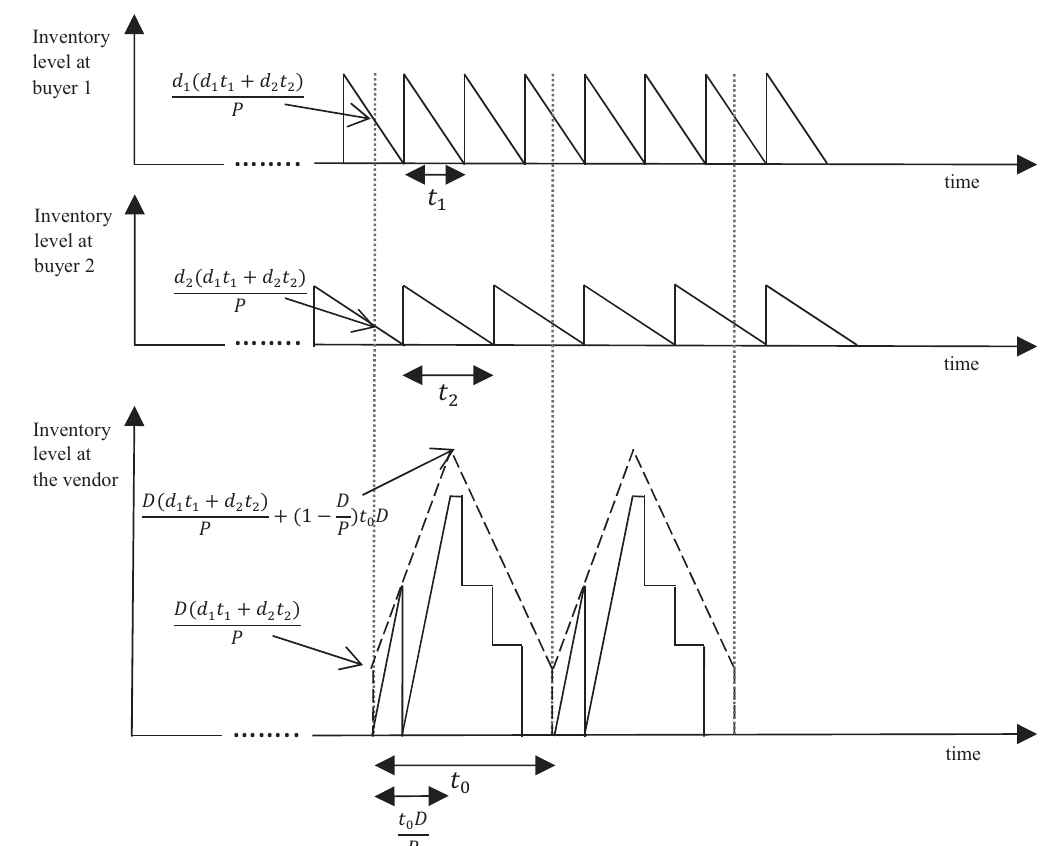
Figure 1. Inventory fluctuations at the buyers and at the vendor. The dotted line represents the inventory fluctuations for the total